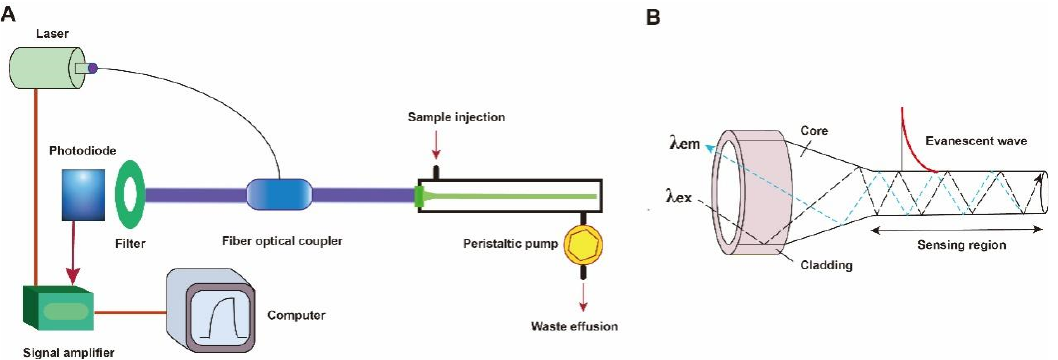
Figure 3. ( A ) The components of a typical fluorescent FOEW sensor; ( B ) the structure of the tapered fiber and the evanescent wave generated vertical to the fiber surface.